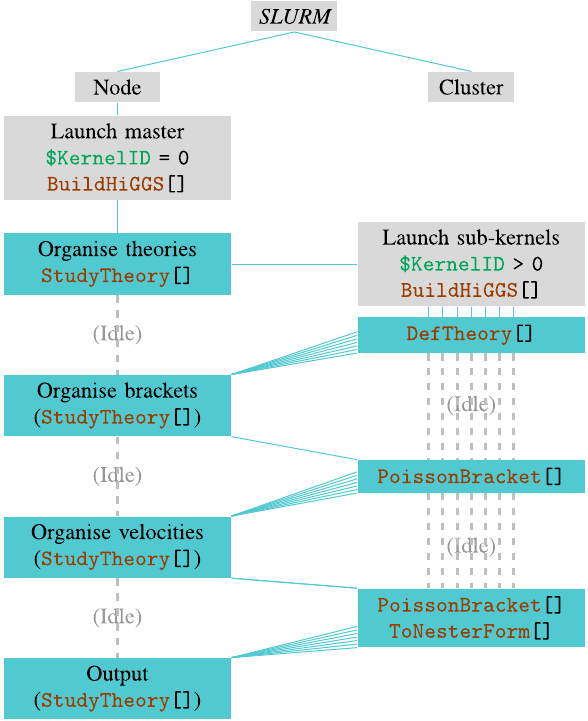
Fig. 2 The parallelisation in HiGGS is not sophisticated, but it allows forpragmaticscalingoftheanalysistosurveys.Alargebatchoftheories can be broken via SBATCH directives over computation nodes, with a reasonable group size of one theory per core per node. Each node is controlled by a master kernel, which coordinates its portion of the survey through a single call to StudyTheory[] . Three phases of work are then delegated to the sub-kernels. First, the constraint shell is partially reconstructed from the literature knowledge of the theory. The commutators between all constraints of all theories are then evaluated in parallel. Finally, the velocities of the constraints are decomposed into ther constituent Poisson brackets: these are evaluated and simplified in parallel before returning to the master kernel for synthesis of the